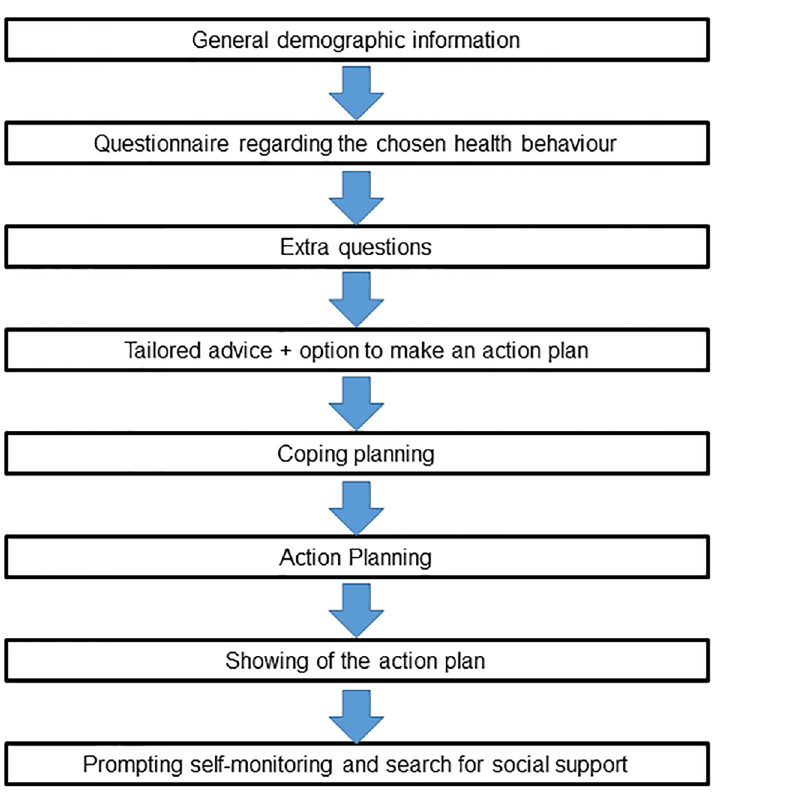
Fig 1. Overviewof the start